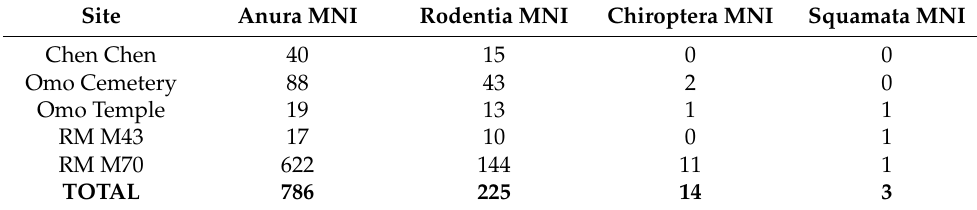
Table 4. Anurans and other possible owl prey taxa MNI by